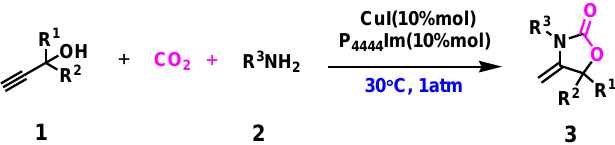
Scheme 1. Cycloaddition reaction of propargyl alcohol and amines with CO 2 .